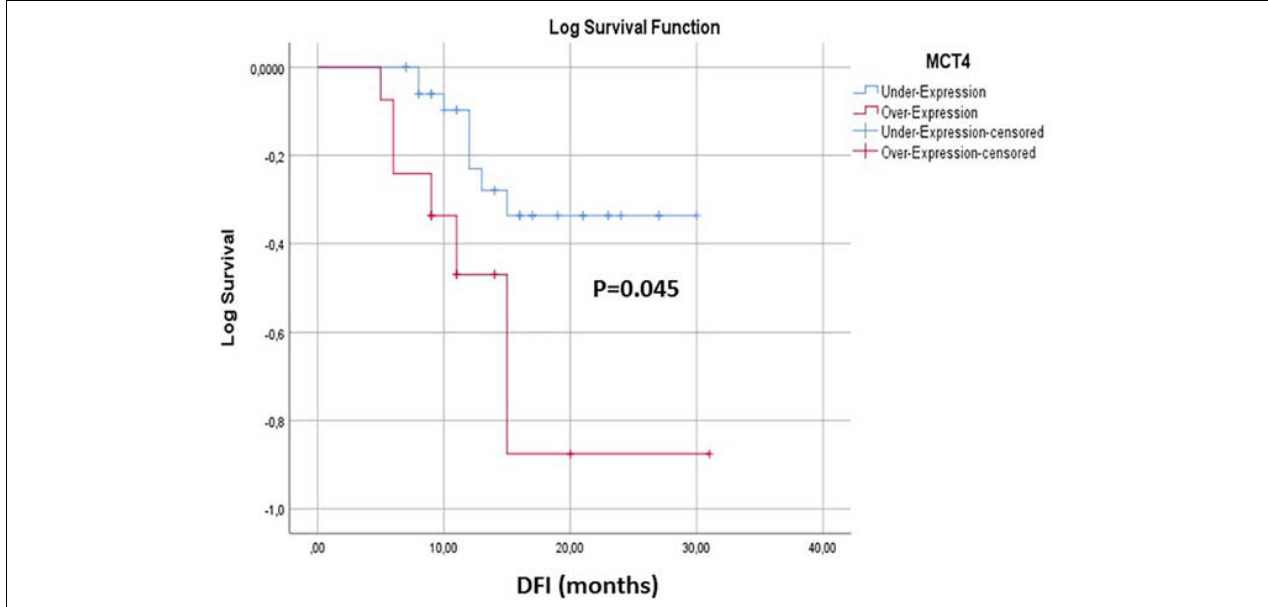
FIGURE 5 | Kaplan–Meier estimates of DFI of early stage NSCLC patients in respect to MCT4 overexpression in